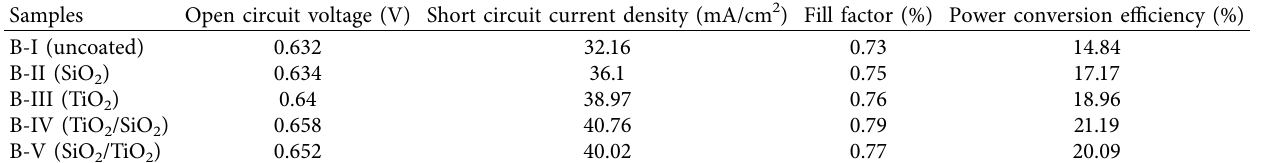
Figure 7: Measured values of the samples under direct sunlight. Table 4: Measured values of samples under a controlled source of